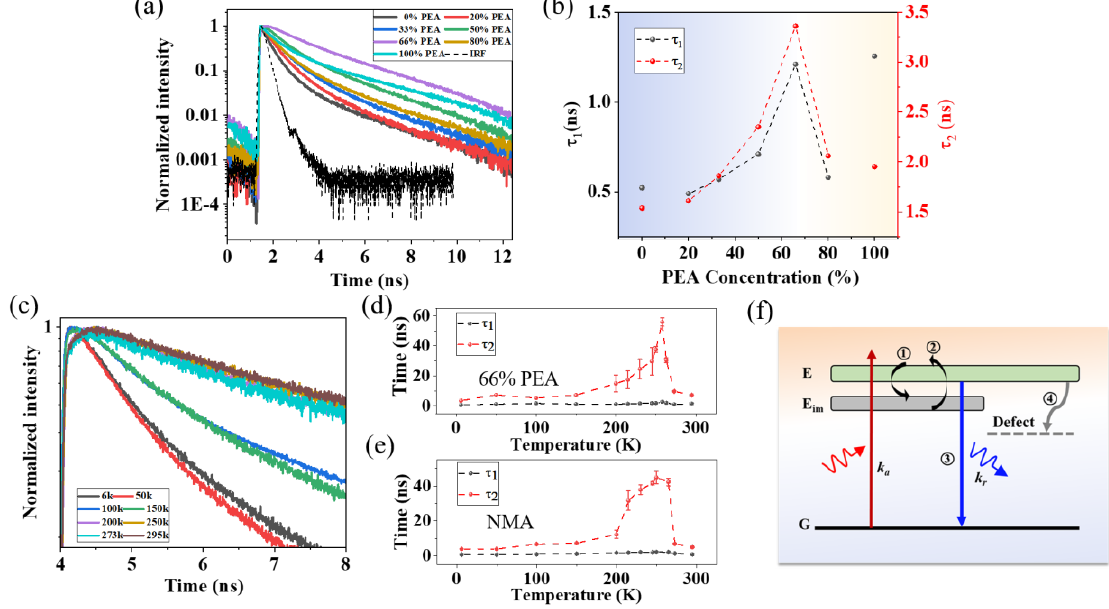
Figure 3. ( a ) TRPL spectra of mixed organic bulky spacer cations RPP films under the same 33uw light excitation. ( b ) τ 1 and τ 2 processes as a function of PEA components. ( c ) TRPL spectra of 66% PEA sample with different temperature. ( d ) τ 1 and τ 2 processes in 66% PEA samples as a function of temperature. ( e ) τ 1 and τ 2 processes in single NMA samples as a function of temperature. ( f ) Schematic illustration of the PL enhancement mechanism of RPP Perovskite by mixed bulky spacer